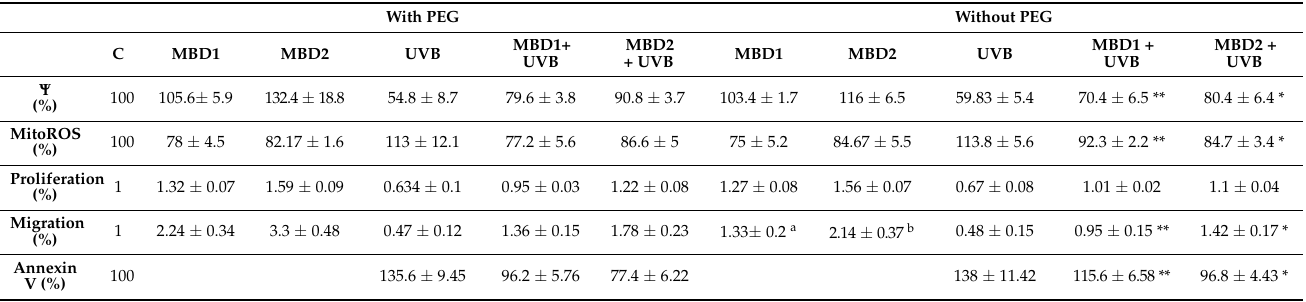
Table 1. Effects of MBD with/without PEG on ARPE-19 cells.